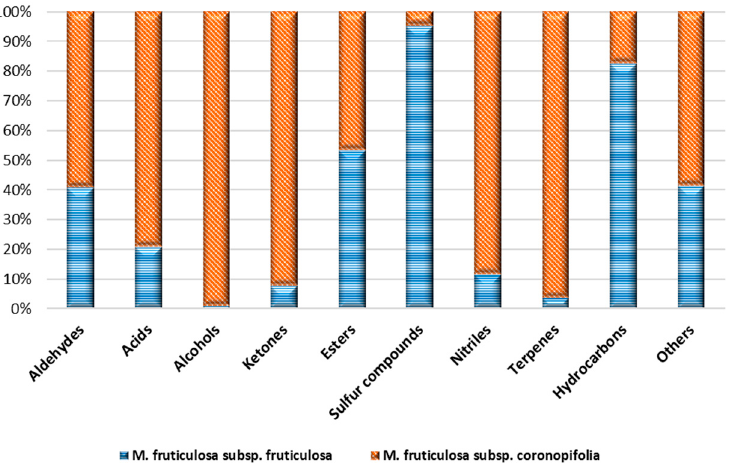
Figure 2. Normalized percentage composition, as classes of substances, of the volatile profile of M. fruticulosa subsp. fruticulosa and subsp. coronopifolia extracts.